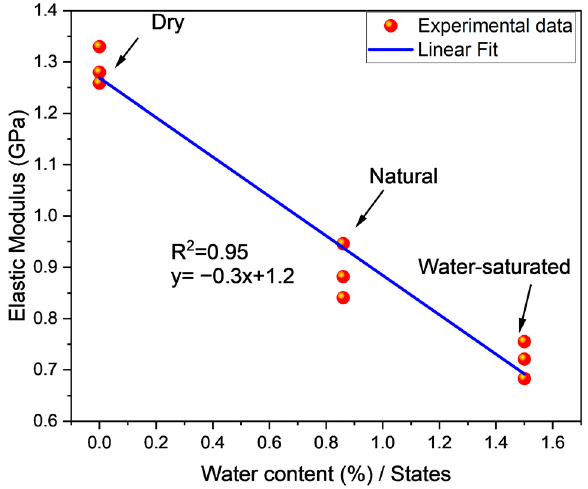
Figure 7. Correlation of different states of coal and elastic modulus.